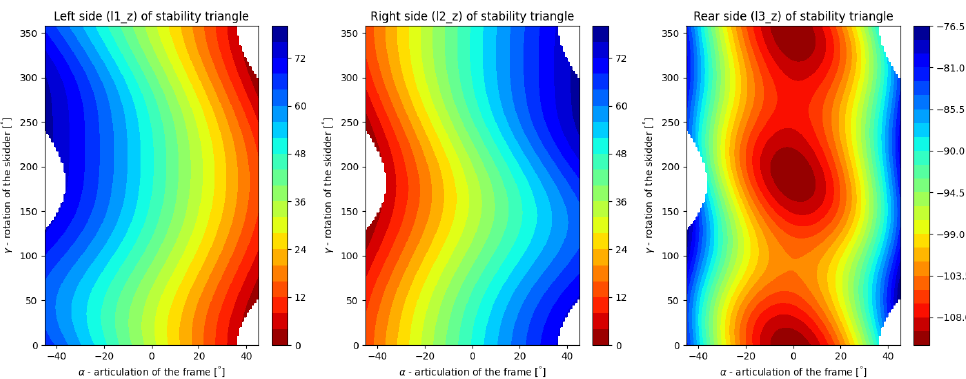
Figure 12. Comparison of stability for a full water tank (C2 config.) and the same tank with additional front load (C4 config.) The color bars show values computed as C2 minus C4 distances [mm] of the gravity vector to the tipping lines. Positive values mean that the C2 configuration is more stable than C4. Negative values mean that the C4 configuration is more stable than C2.